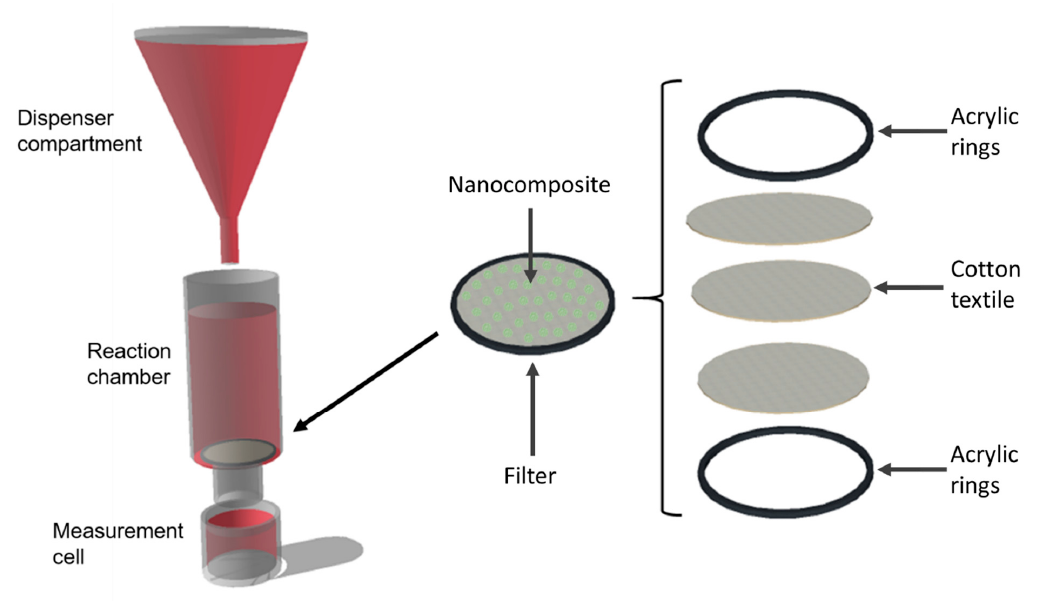
Figure 2. Bioreactors schematic. The bioreactors consisted of a dispenser compartment, a reaction chamber and a measurement cell. The reaction chamber contained a textile-based biofilter with free or immobilized laccase molecules as biocatalysts. The dispenser compartment was set to release a drop of the artificial wastewater every second.